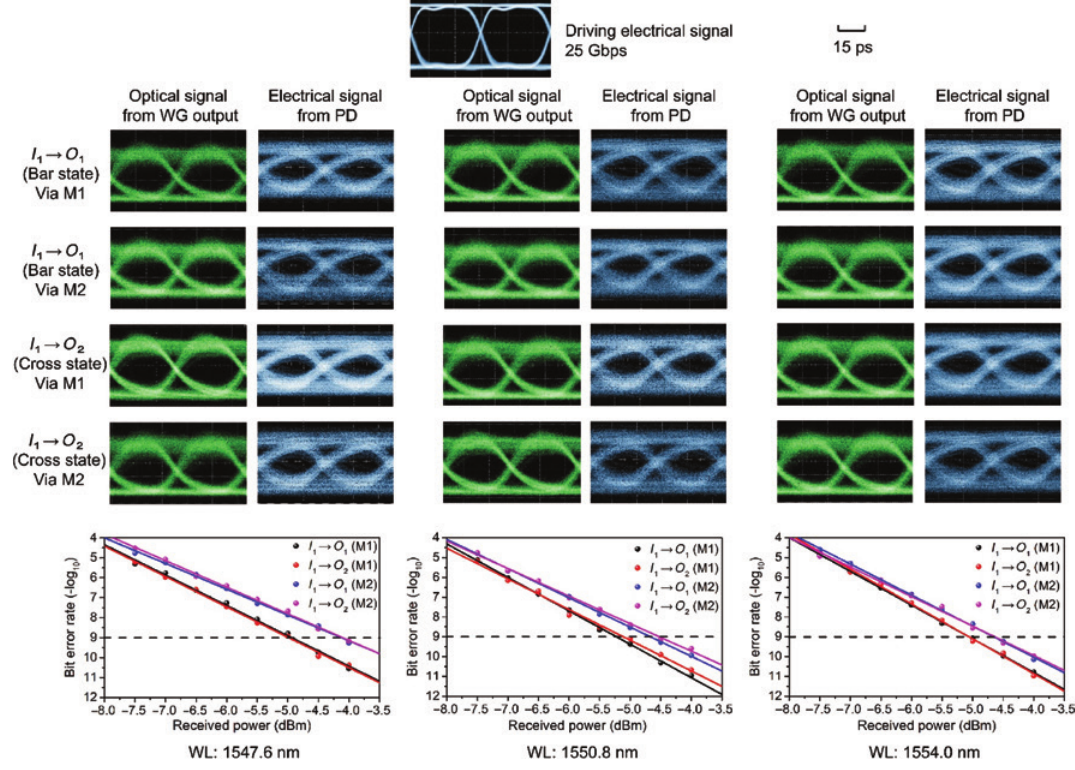
Figure 8: 25 Gbps eye-diagram derived from optical signals from monitor waveguide outputs (odd-column) and electrical signals from photodetectors (even column), and the corresponding bit-error-rates of the